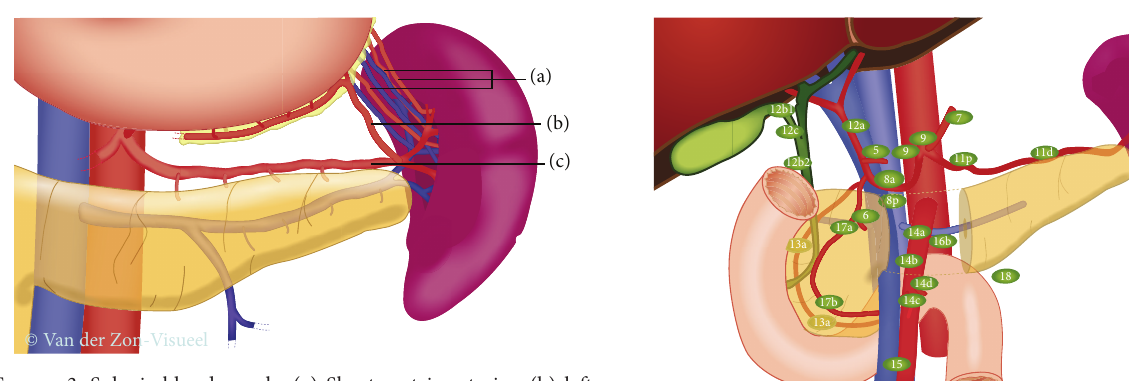
Figure 3: Splenic blood supply. (a) Short gastric arteries; (b) left gastroepiploic artery; (c) splenic artery.